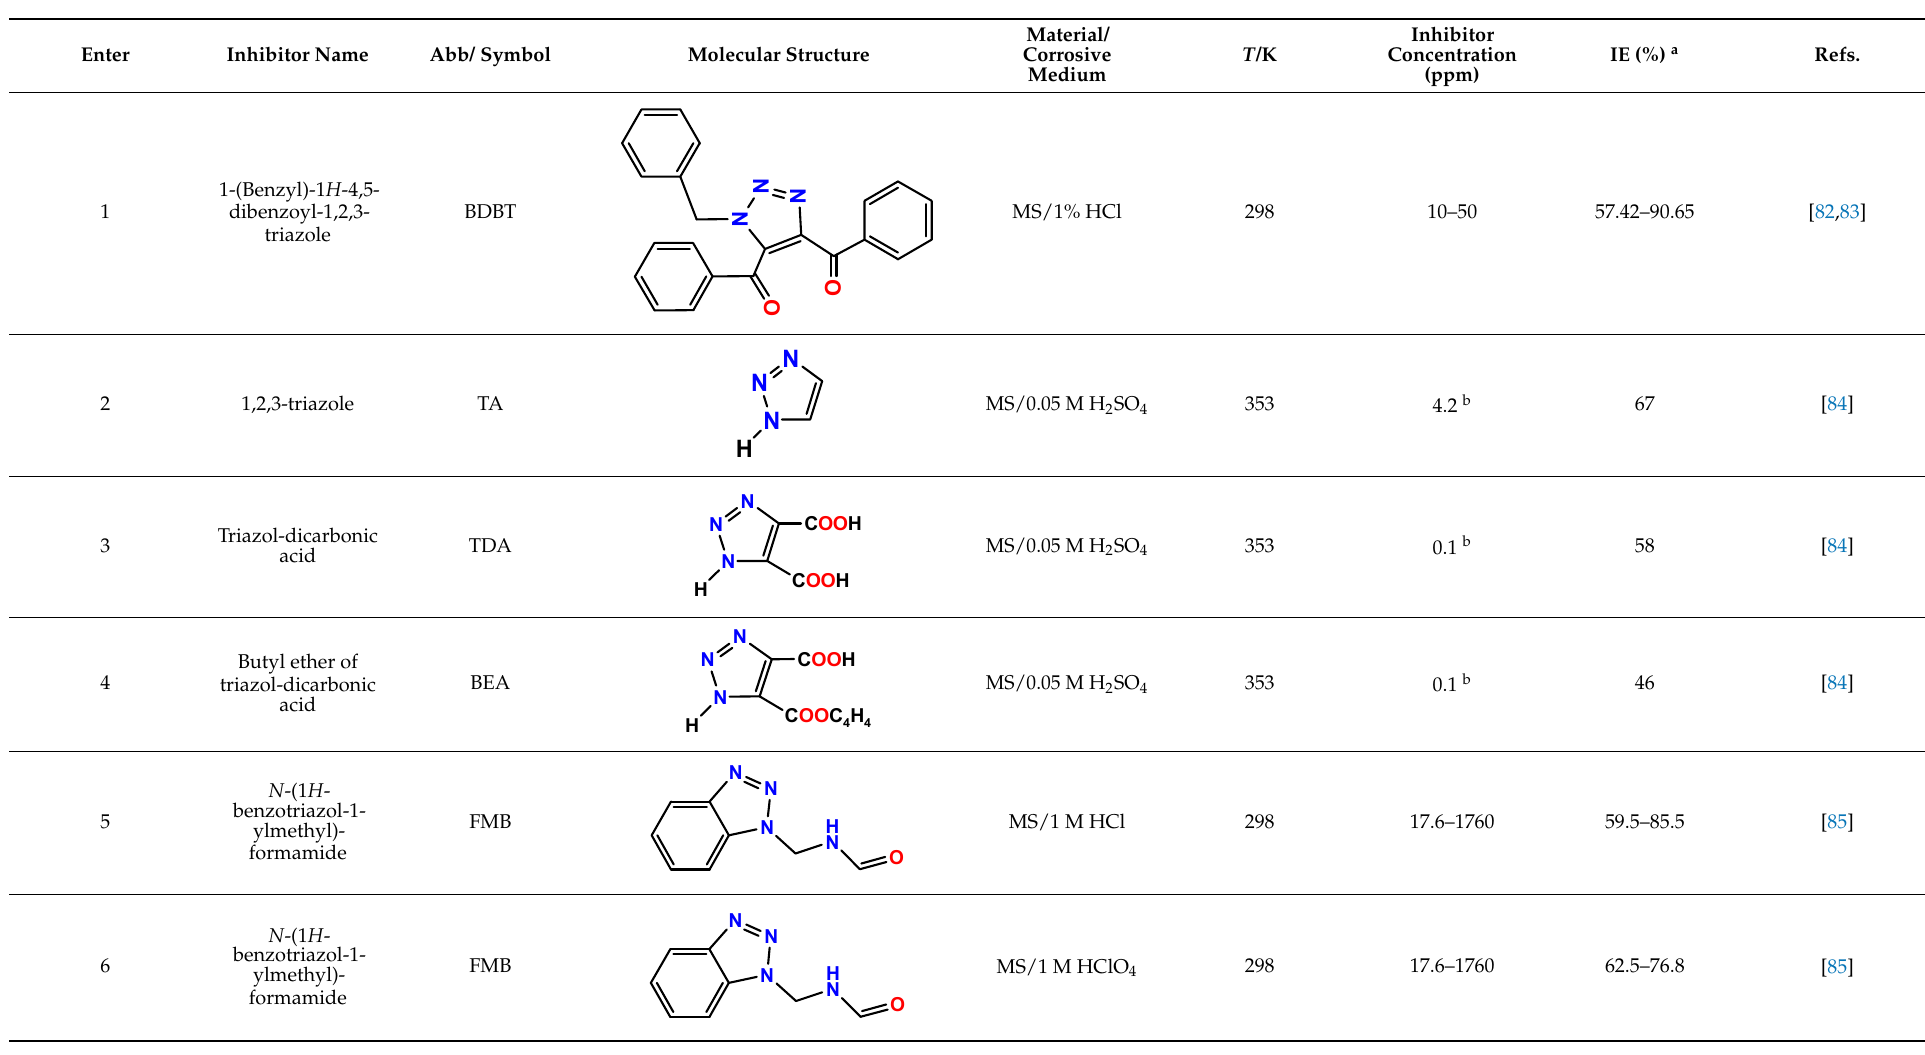
Table 1. 1,2,3-triazole derivatives as corrosion inhibitors.